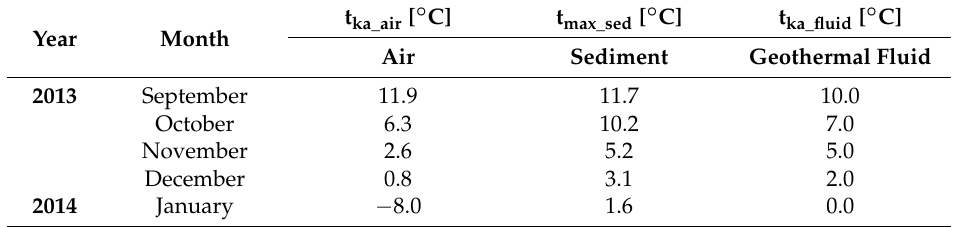
Table 2. The monthly mean air temperature (t ka_air ) [24], the maximum sediment temperatures (t max_sed ) and the geothermal fluid temperatures (t ka_fluid ) in Vaasa in the measurement period 2013–2014. t ka_air [°C] t max_sed [°C] t ka_fluid [°C] Year Month Air Sediment Geothermal Fluid 2013 September